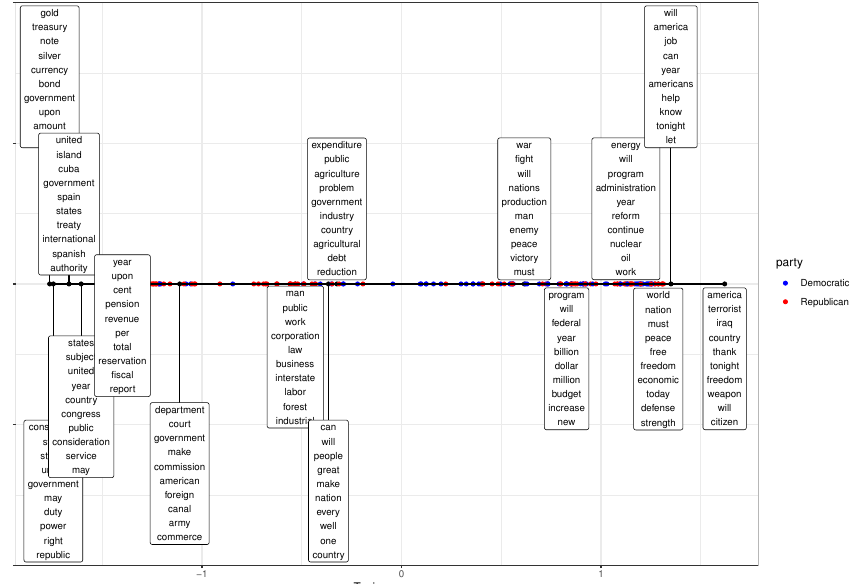
Figure 7. Topic scores learned via Topic Scaling (15